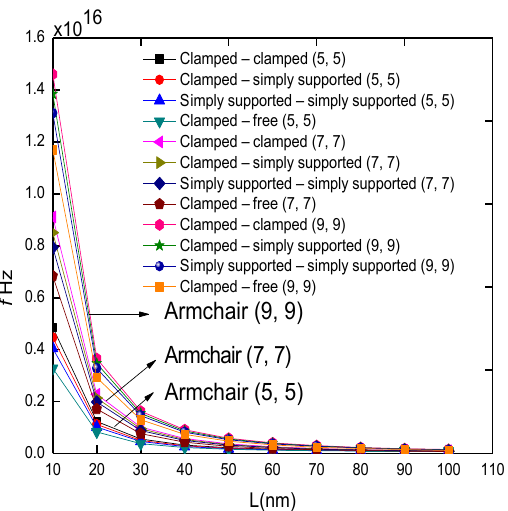
Figure 4. Variations of fundamental frequencies with length ( L ) for armchair (5, 5), (7, 7) and (9, 9) when radii R = 678nm, R = 1356nm, and R = 2034nm, h = 0 . 1nm for different bound- ary conditions.